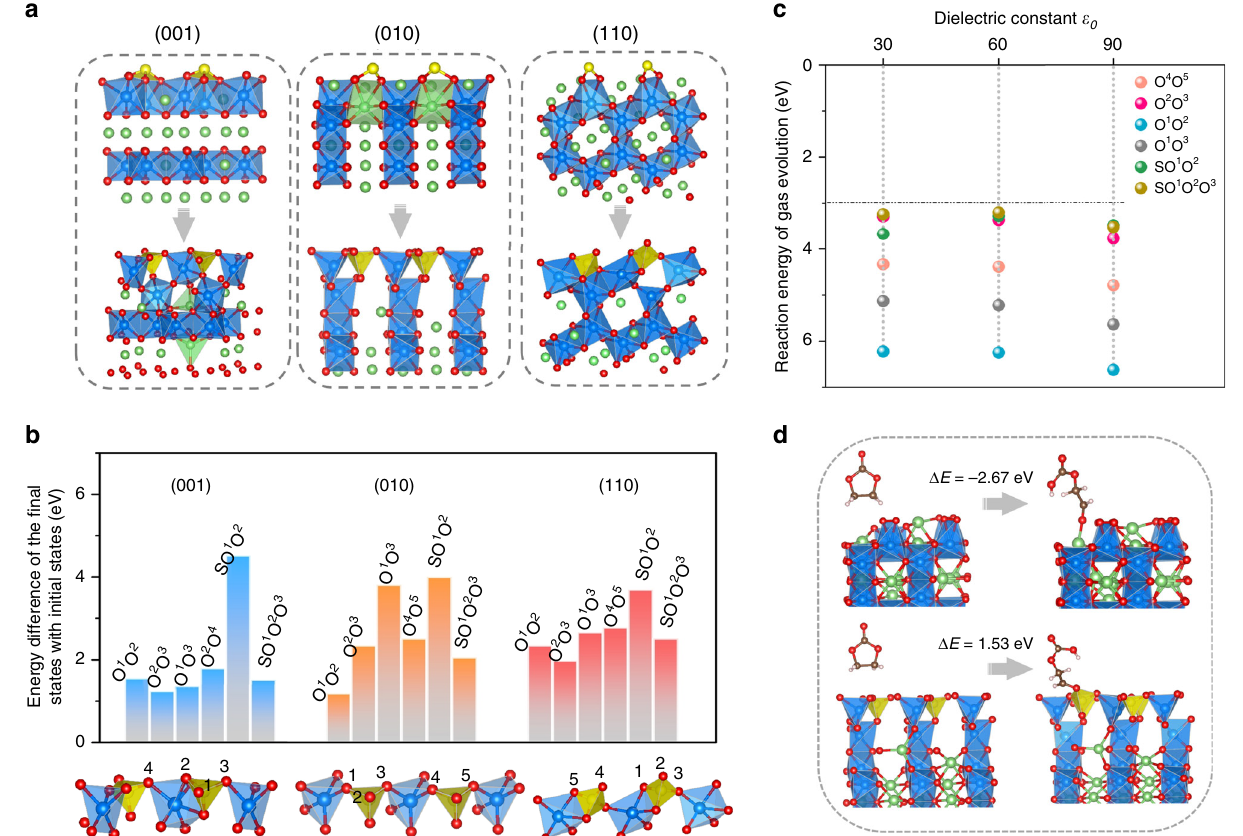
Fig. 3 The surface structures of Li 2 MnO 3 with sulfur deposition and the stability of surface O after delithiation. a Structures of the (001), (010), (110) surfaces with sulfur deposition (upper) and the reconstructed con fi gurations upon 37.5% delithiation (below). The yellow spheres represent S ions. b Energy required for gas evolution on the three delithiated surfaces. Each exposed O atom on the surface is labeled with a different number and then is grouped together or with S atom to form the potential gas products, such as O 2 , SO 2 , or SO 3 . Each slab with gas evolution to the vacuum is taken as the fi nal state. c Reaction energy of (010) surface oxygen evolution in implicit solvents with different dielectric constants. d EC molecular adsorption on delithiated (010) surface before and after surface treatment and ring opening of cyclic